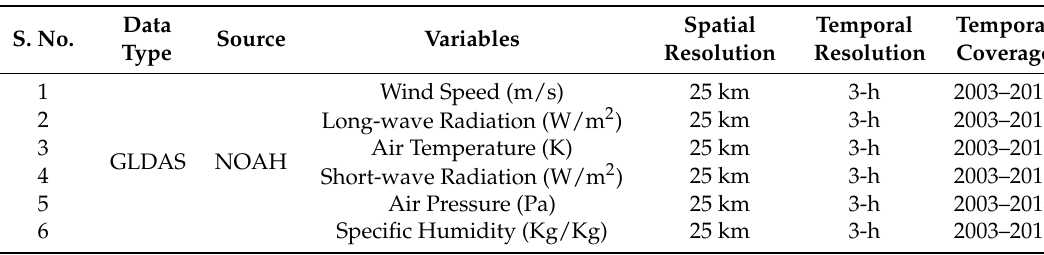
Table 1. Characteristics of the climate parameters downloaded from Global Land Data Assimilation System (GLDAS) for a period (2003–2013) across the Kabul River Basin. S.